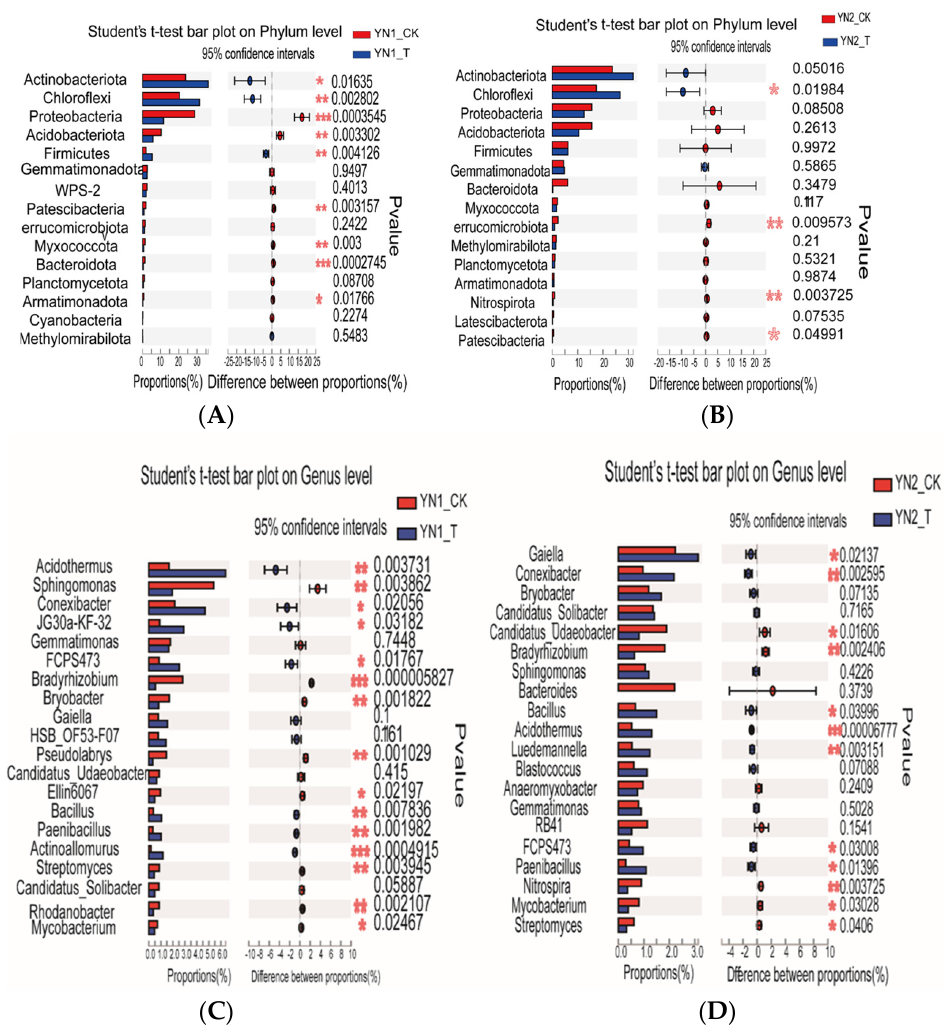
Figure 9. Changes in the relative abundance of ( A ) bacterial phyla in YN1 soil; ( B ) bacterial phyla YN2 soil; ( C ) bacterial genera in YN1 soil; ( D ) bacterial genera in YN2 soil. All soils were triple-fumigated and had been used to produce ginseng. ‘Triple fumigation’ refers to the simultaneous application of chloropicrin, dimethyl disulfide and metham sodium. The t -test reported the statistical differences (asterisked, * 0.01 < p ≤ 0.05; ** 0.001 < p ≤ 0.01; *** p ≤ 0.001) between the means of three replicates within the phylum or genus levels.